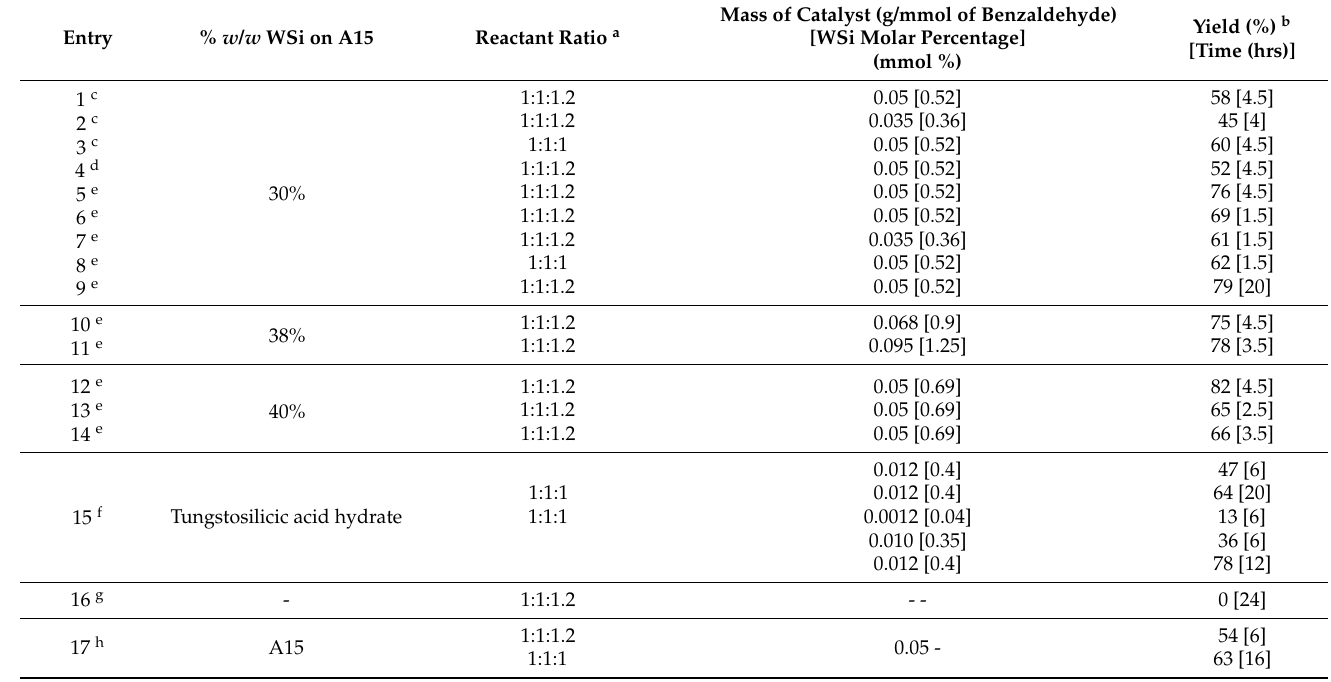
Table 2. Condition optimization using WSi/A15